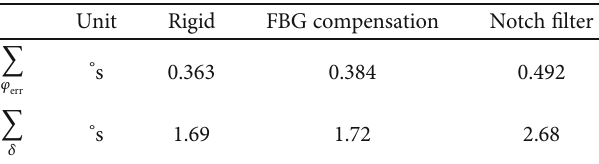
Figure 14: Trajectory performance of the miniature launcher. Table 4: Performance